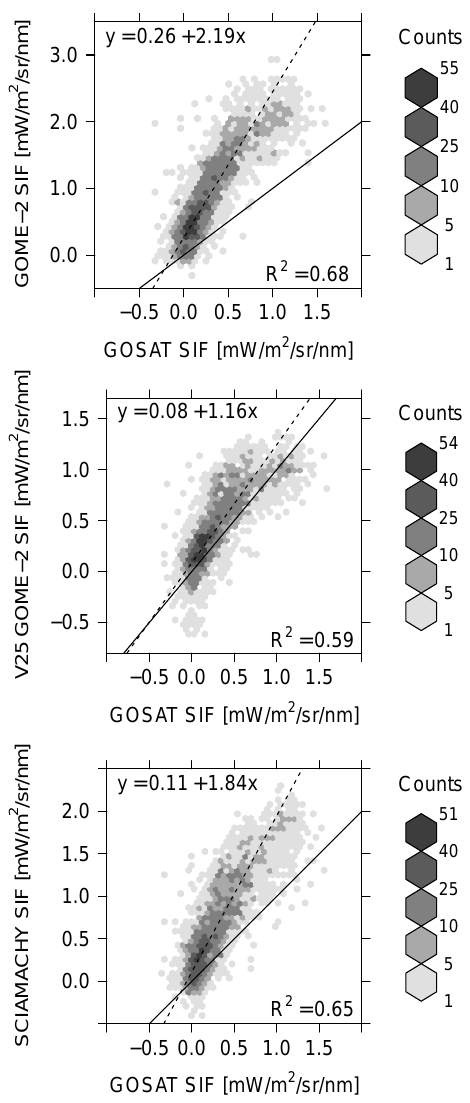
Figure 15. SIF retrieval results from GOSAT (evaluated at 755nm, Köhler et al., 2015) versus SIF retrieval results from the presented algorithm and V25 results provided by Joiner et al. (2014). SIF av- erages from June 2009 to August 2011 (rastered on a 2 ◦ × 2 ◦ grid) have been used. Each evaluated grid box contains at least 26 re- trievals using GOSAT data, included GOME-2/SCIAMACHY SIF retrievals own a cloud fraction lower than 0.5. The one-to-one line (solid line) is depicted as well as a linear fit (dotted